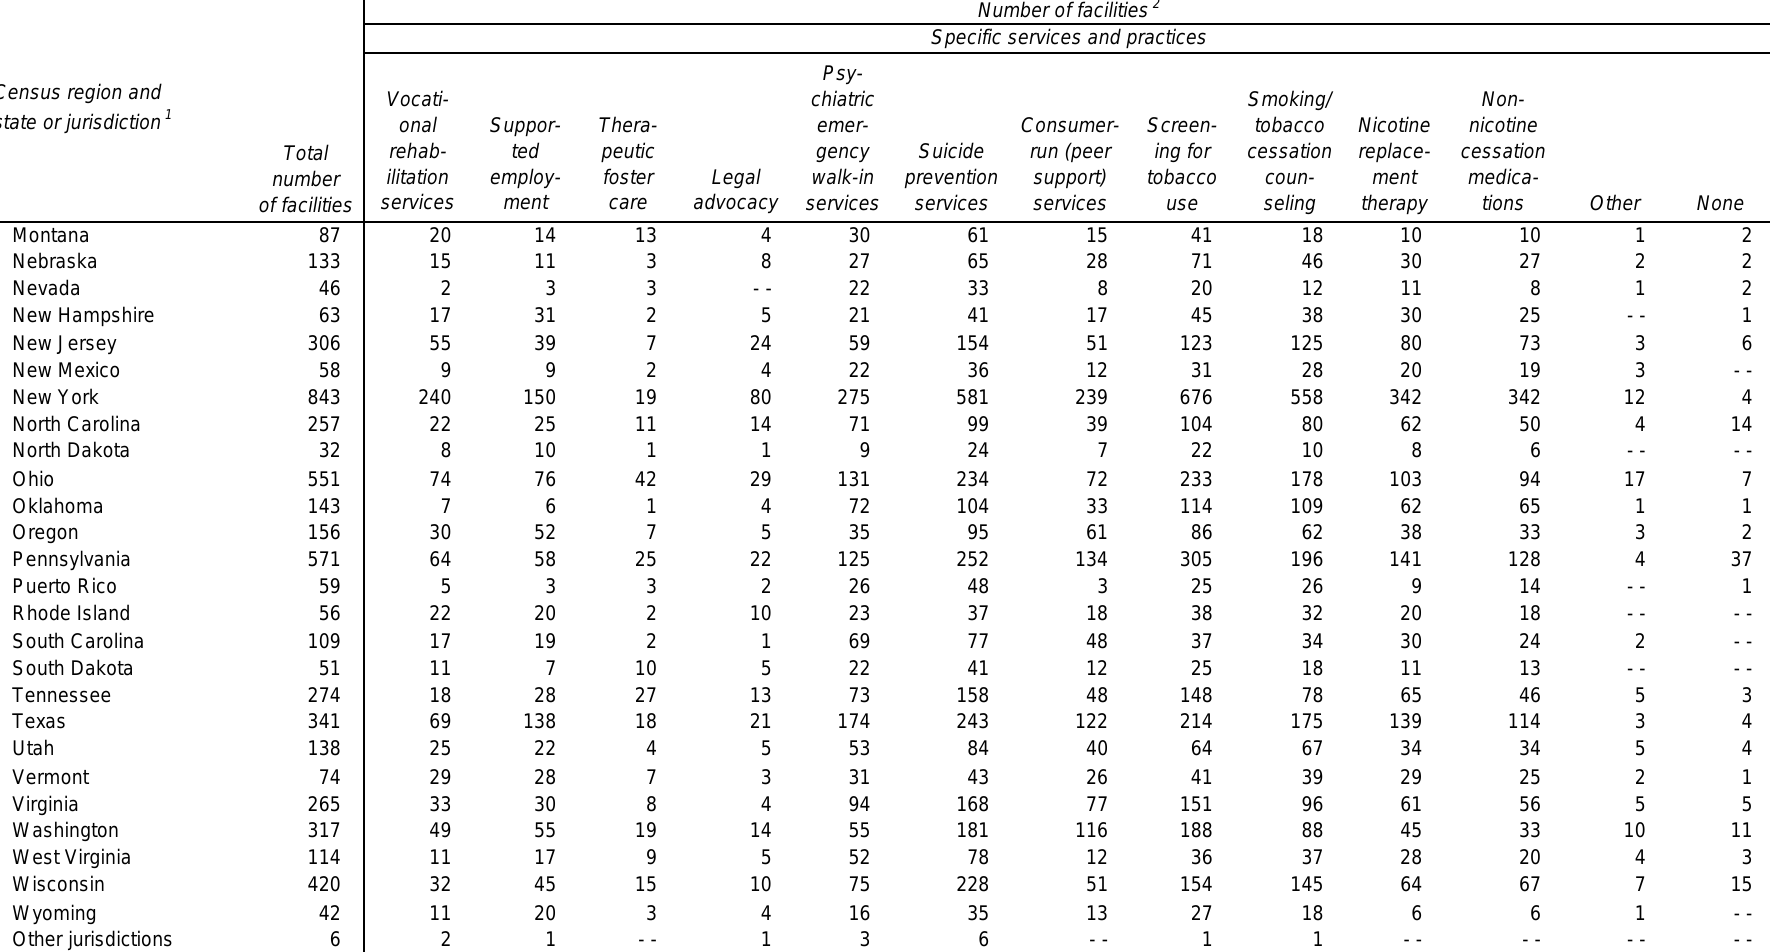
Table 3.8a. Mental health treatment facilities offering specific services and practices, by Census region and state or jurisdiction: Number, 2017